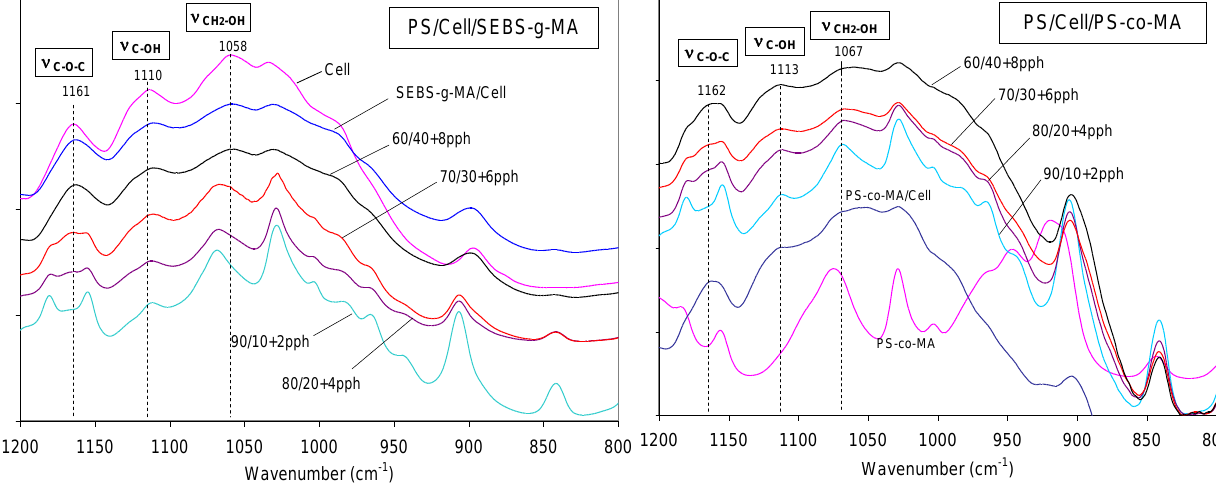
Figure 11. FT-IR spectra of PS/Cell compatibilized with SEBS- g -MA and PS- co -MA, in the region 800–1,200 cm −1 (compatibilizer amount in pph).